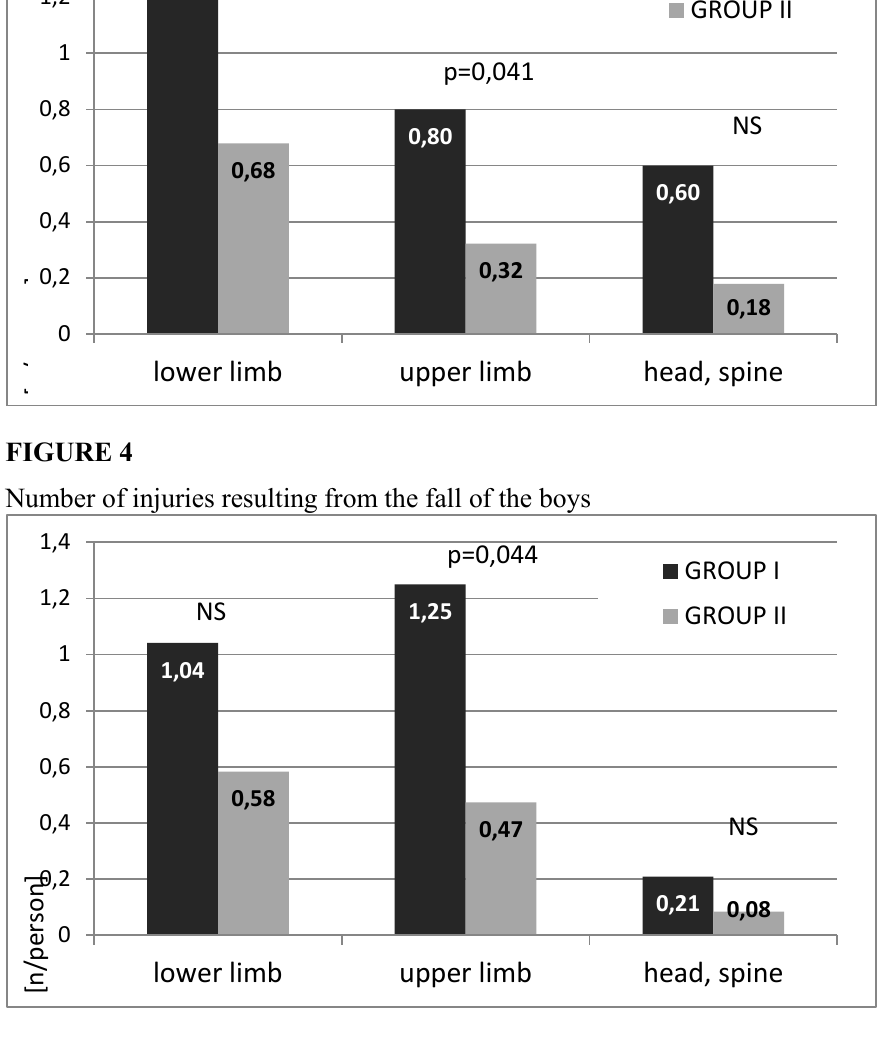
concerned children with visual impairment (r=0.6 p=0.000) rather than healthy children (r=0.53